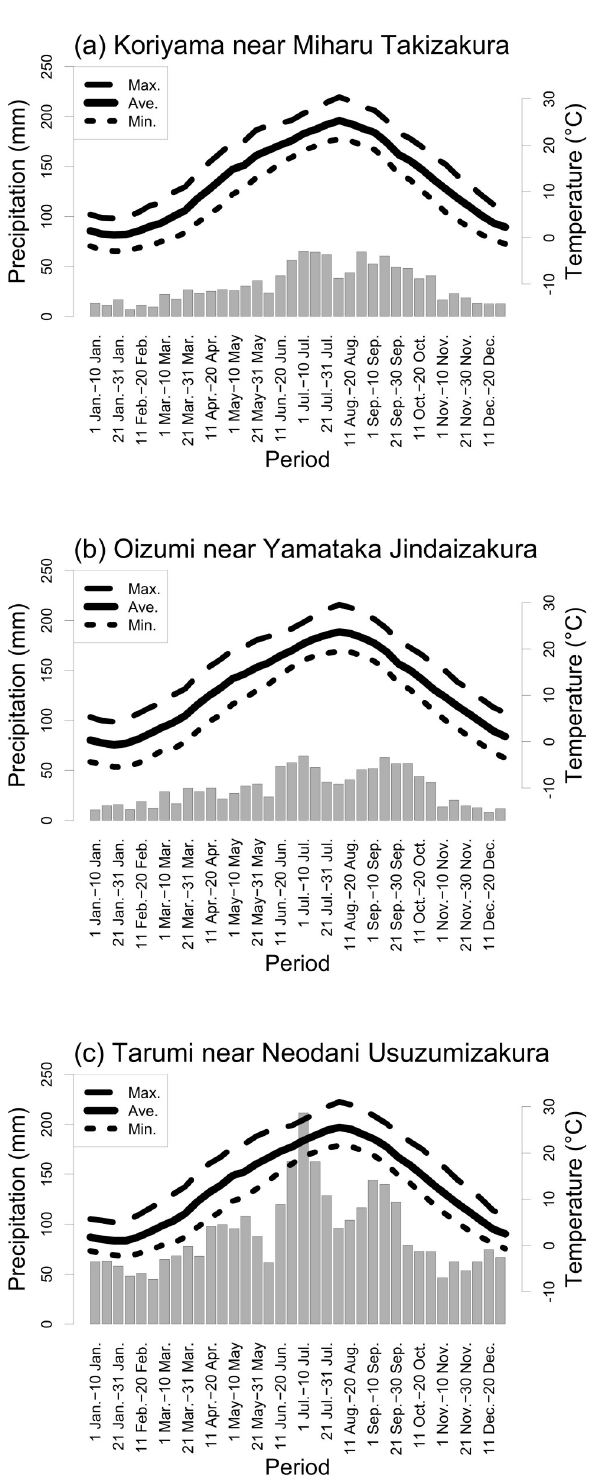
Fig 2. Ten-day average temperature (lines) and precipitation (boxes) based on observations from 1991 to 2020 at Koriyama AMeDAS station near Miharu Takizakura, Oizumi AMeDAS station near Yamataka Jindaizakura, and Tarumi AMeDAS station near Neodani Usuzumizakura [28].